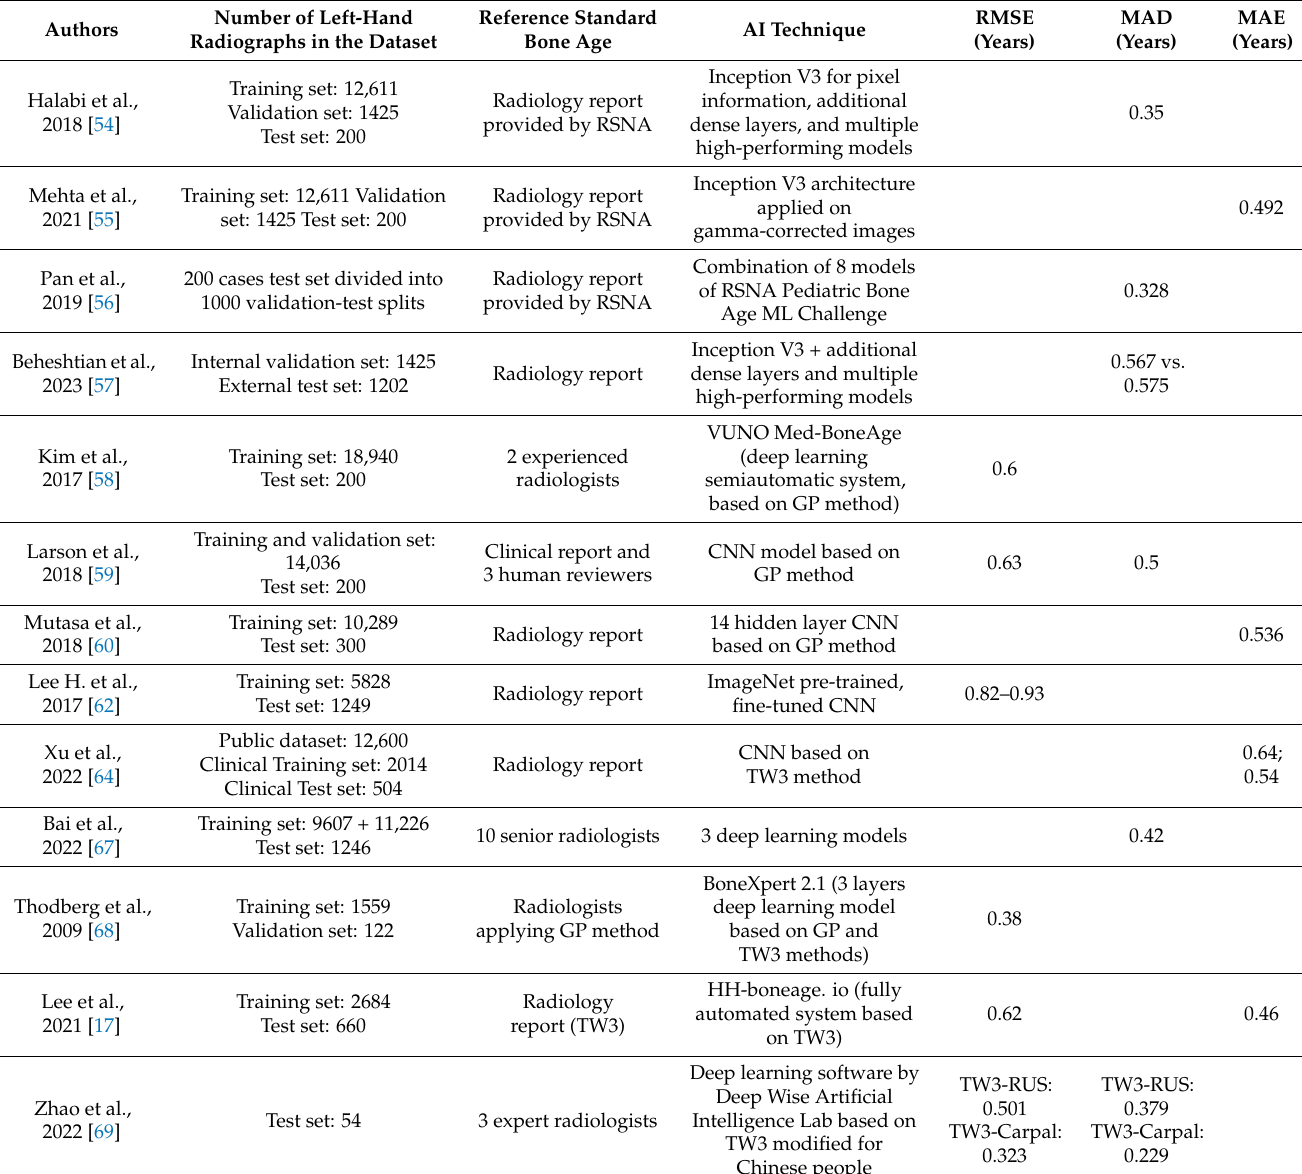
Table 1. Main characteristics of studies based on hand radiograph analysis for bone age